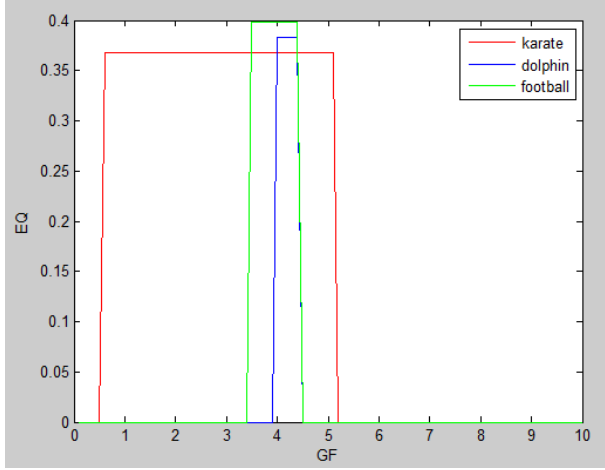
Figure 6. The selection of GF .